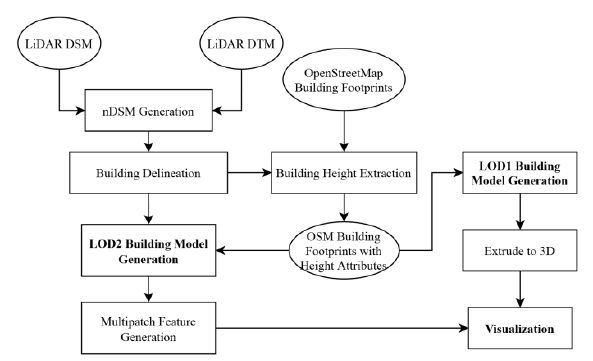
Figure 1. General workflow for generating the LOD1 and LOD2 3D city models.